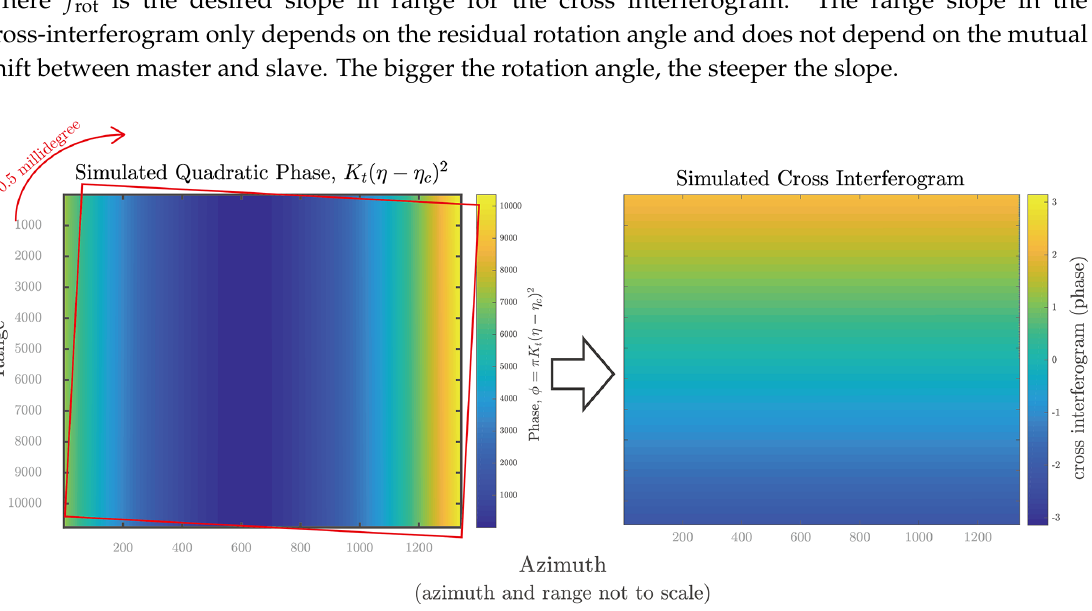
Figure 6. The effect of image rotation on the cross interferogram. A simulated rotation angle of 0.5 millidegree is reflected to the cross-interferogram as a linear slope. For a simulated dataset with 10,770 samples in range, the cross-interferogram phase goes approximately from 2.2 to − 2.2